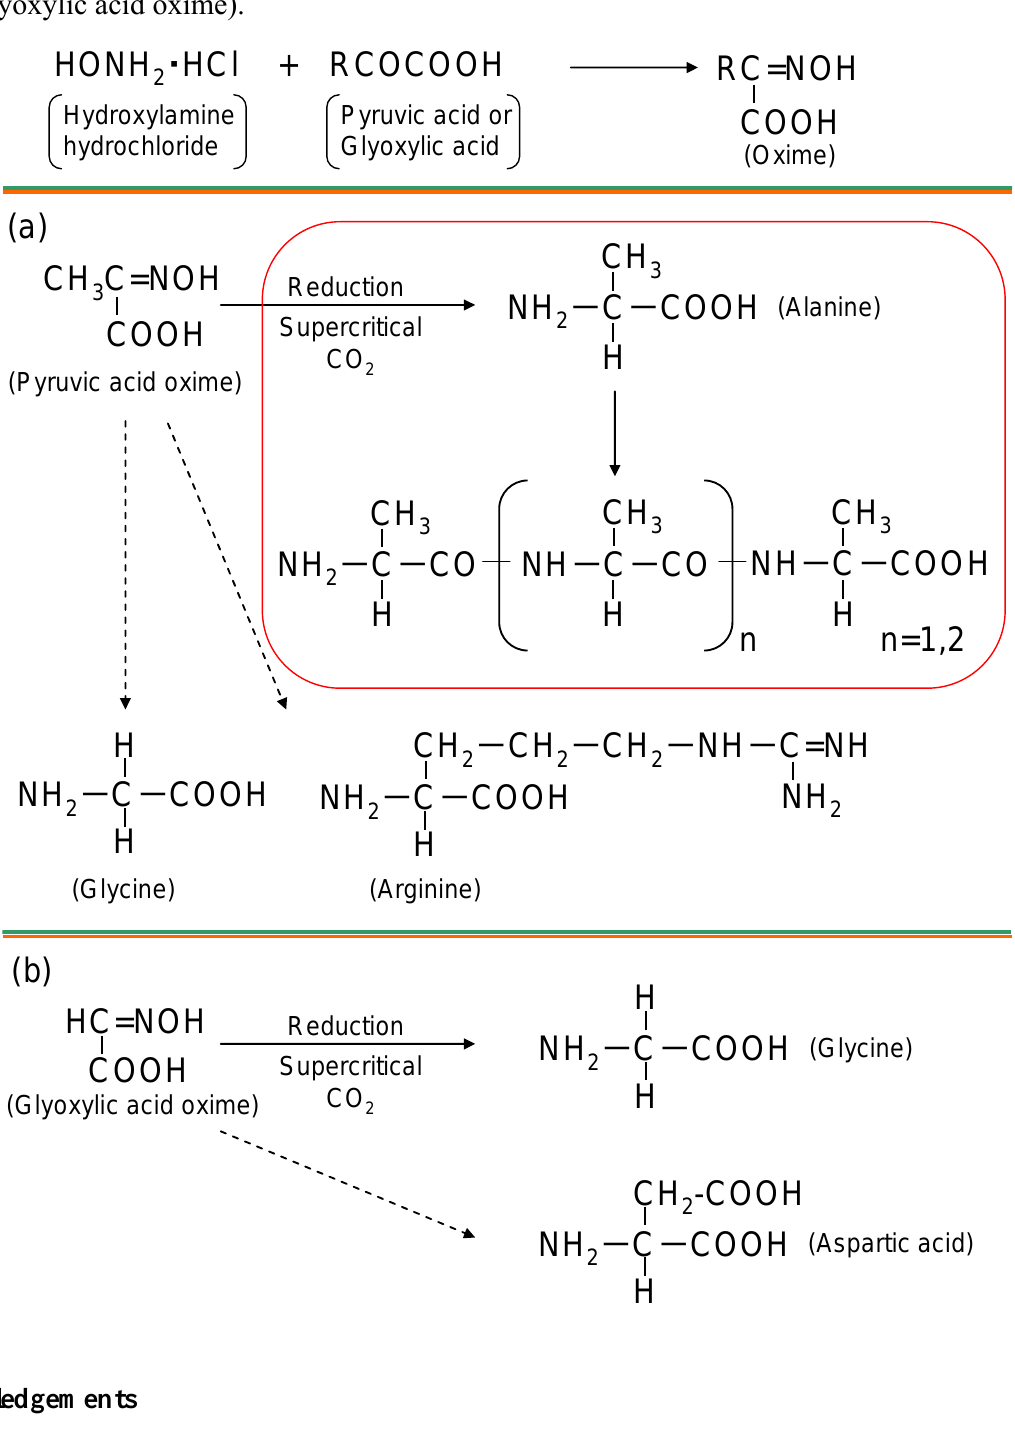
Figure 4. Reaction overview of the supercritical CO Hydroxylamine + Pyruvic acid (Pyruvic acid oxime) (b) Hydroxylamine + Glyoxylic acid (Glyoxylic acid